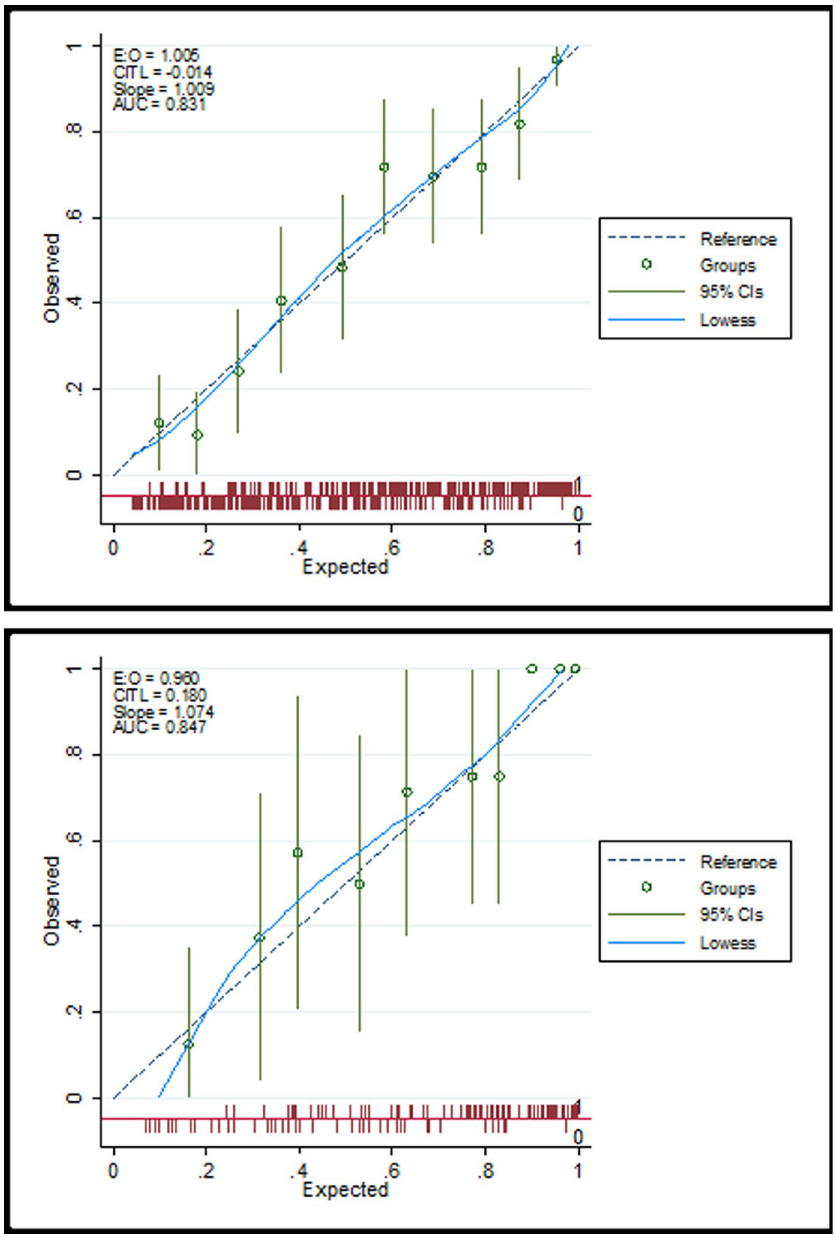
Fig 3. Calibration plot for observed and predicted probabilities of NAFLD (neck circumference as the independent variable) among (a) Female and (b) male participants. AUC = area under the receiver operating characteristic (ROC) curve; CI = confidence interval; CITL = calibration in the large; E:O = Expected:Observed.